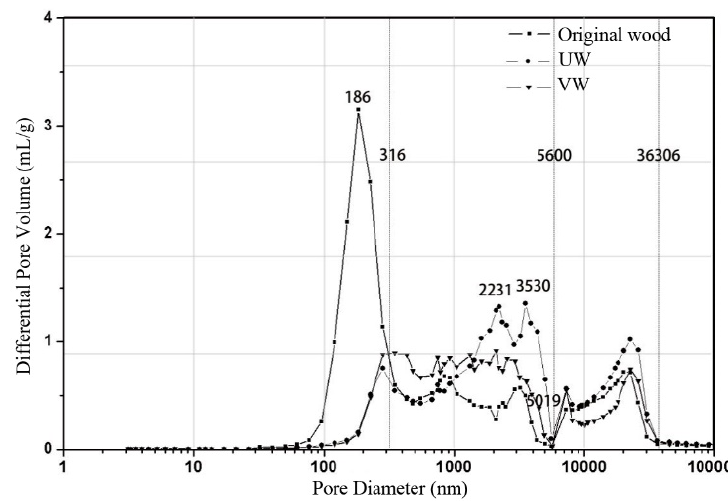
Figure 6. Differential pore volume vs. pore diameter of original wood, UW, and VW.